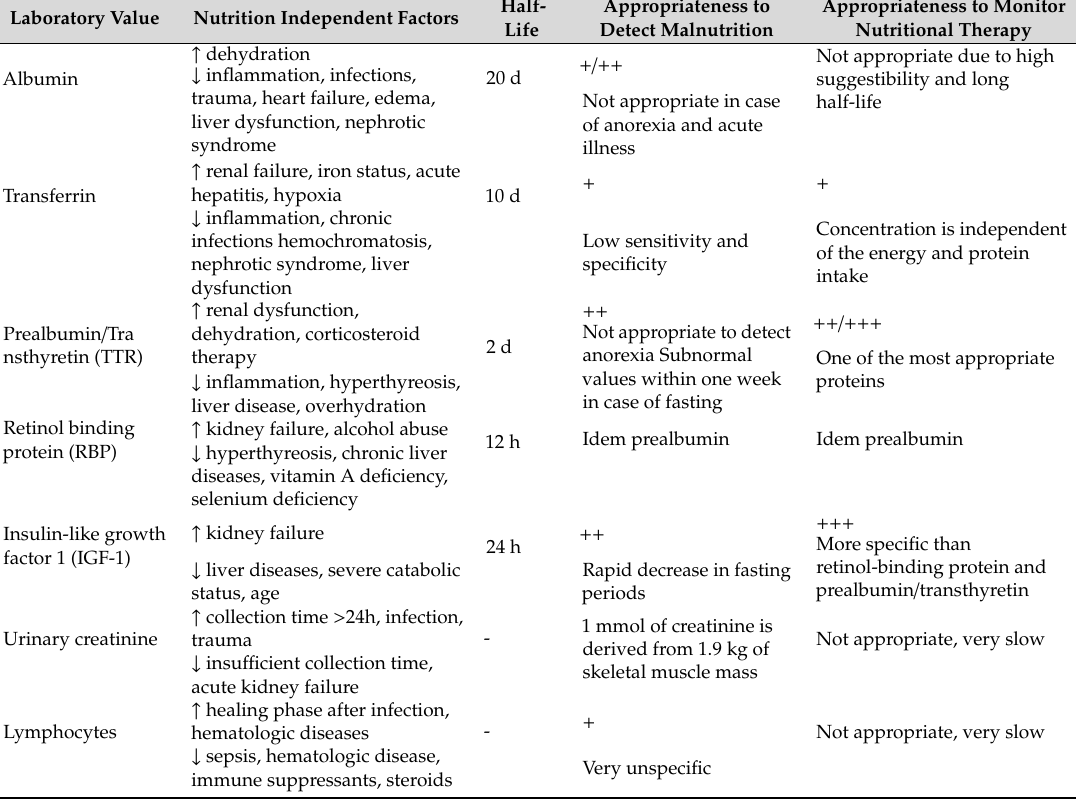
Table 5. Laboratory values to detect malnutrition and monitor nutritional status